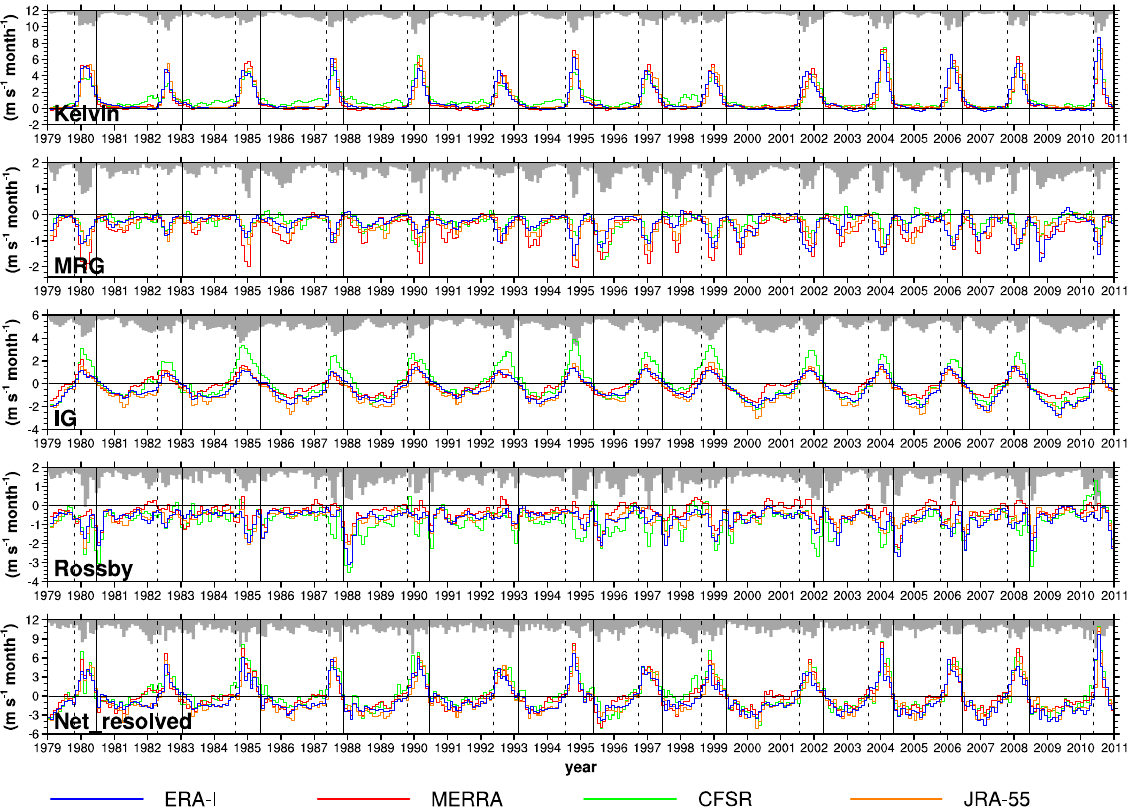
Figure 2. Zonal momentum forcing by the Kelvin, MRG, IG, and Rossby waves averaged over 5 ◦ N–5 ◦ S at 30hPa for the period 1979–2010, as well as the net forcing by all resolved waves (from top to bottom) obtained using the p -level data of ERA-I (blue), MERRA (red), CFSR (green), and JRA-55 (orange). The phase of the maximum easterly and westerly in each QBO cycle at 30hPa is indicated by the dashed and solid vertical lines, respectively. The difference between upper and lower bounds of the wave forcing calculated from each data set is also indicated (gray